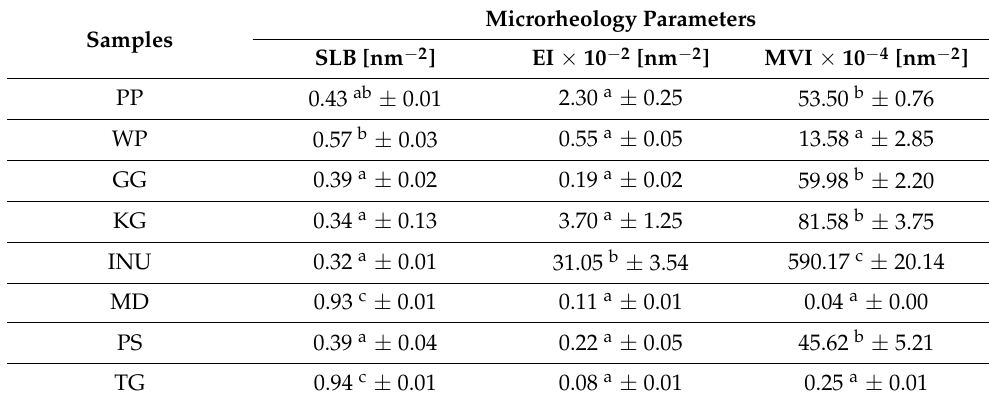
Table 1. Comparison of the microrheological parameters of the analyzed biopolymers.